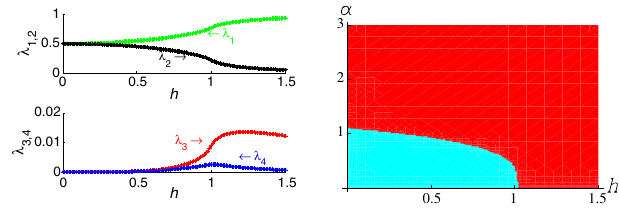
FIG. 3. Left: Plot of the four eigenvalues of ρ for L ¼ 2 , as a A function of h . The solid lines depict analytical results, while the crosses show the numerical results with N ¼ 200 . (Notice the different scales in the vertical axis between the top and bottom panels.) Right: Contour plot of the sign of the derivative with respect to h of the Rényi entropy for different values of h and α .